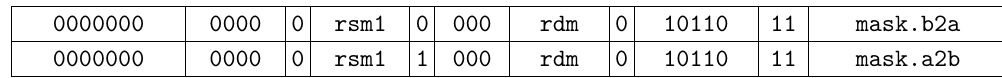
Table 6: Instruction encodings (C-class: conversion).